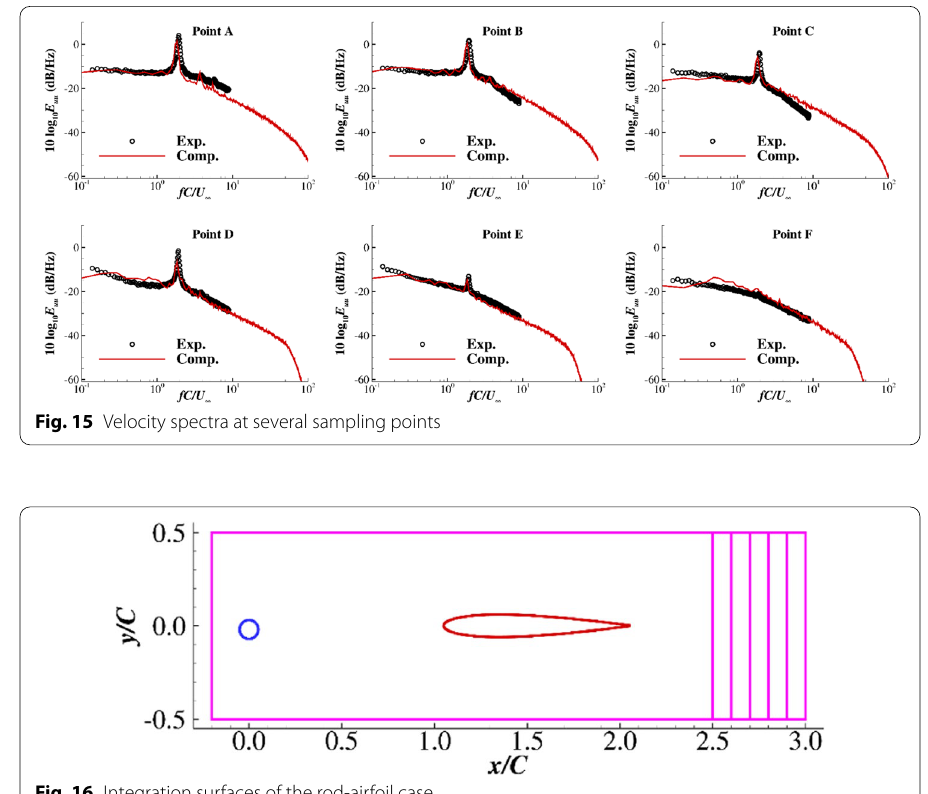
Fig. 16 Integration surfaces of the rod-airfoil